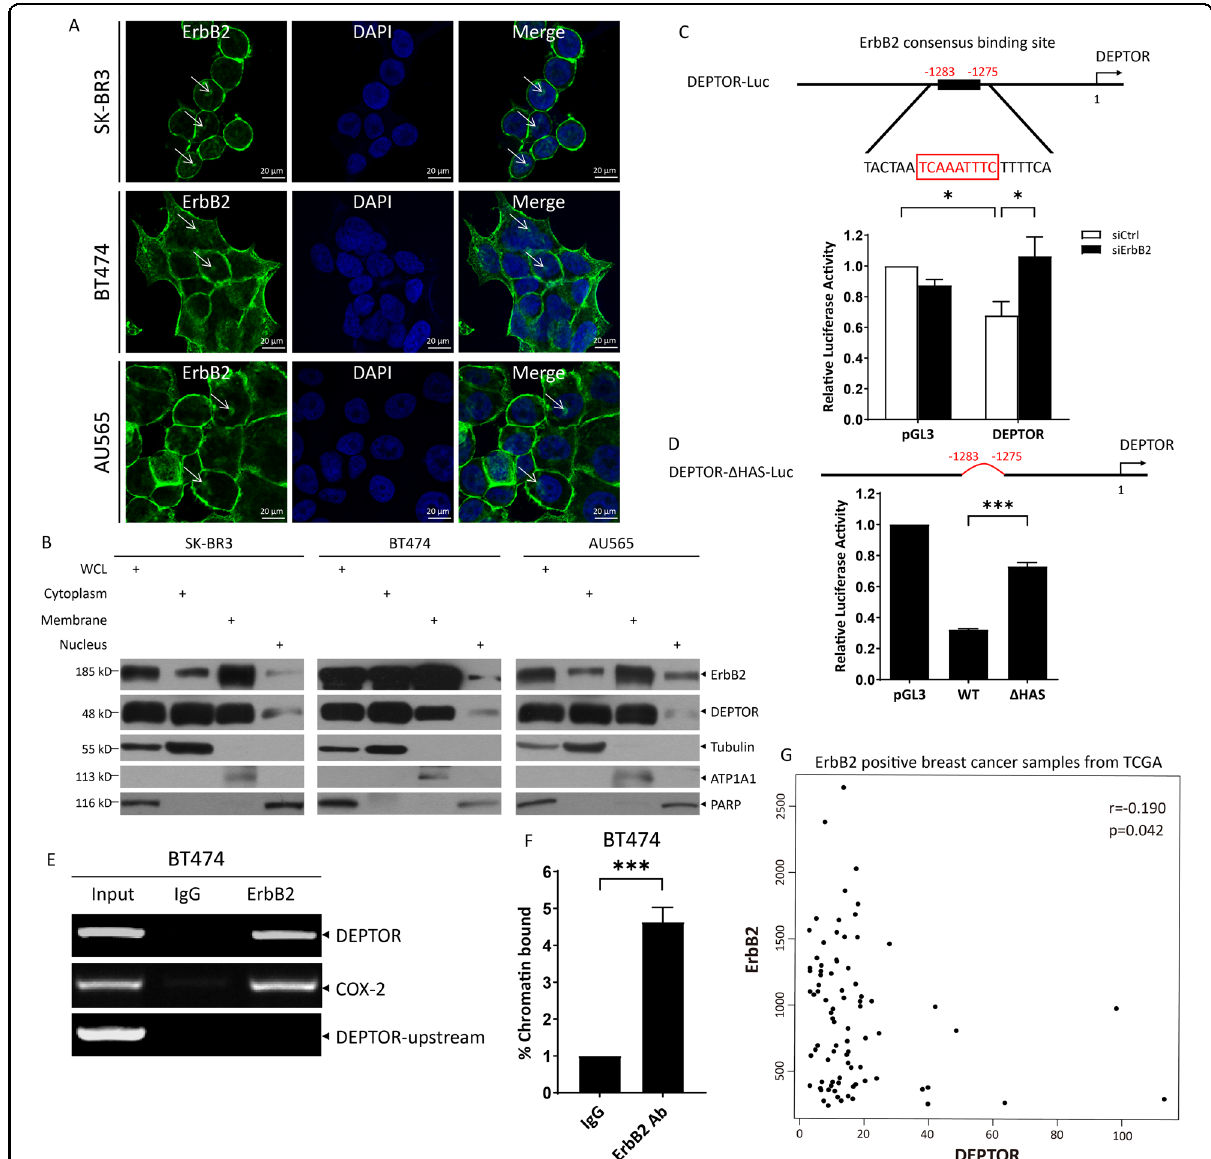
Fig. 2 ErbB2 is translocated to the nucleus and binds to HAS in the DEPTOR promoter. A , B Nuclear translocation of ErbB2: SK-BR3, BT474, and AU565 cells were stained with anti-ErbB2 antibody and photographed using Nikon confocal microscopy ( A ), or harvested for subcellular fractionation, followed by western blotting ( B ). Scale bars represent 20 μ m. Tubulin, ATP1A1, and PARP were used as cytoplasmic, plasmalemmal, and nuclear markers, respectively. C , D Silencing of ErbB2 or deletion of HAS increases DEPTOR transcription. Shown are luciferase reporters under the control of DEPTOR promoter containing the ErbB2 consensus binding site (HAS, − 1283 to − 1275) ( C ) and with HAS deleted (deleting − 1283 to − 1275) ( D ). SK- BR3 cells were cotransfected with the indicated siRNA oligos and luciferase reporter construct (DEPTOR-Luc) for 48 h ( C ), BT474 cells were transfected with the indicated luciferase reporter constructs for 24 h ( D ), followed by luciferase reporter assay. Data from three independent experiments, each run in duplicates, were expressed as mean ± SEM, * p < 0.05, *** p < 0.001. E , F ErbB2 binds to the DEPTOR promoter: fresh BT474 cells were harvested for the ChIP assay with anti-ErbB2 antibody or normal IgG, followed by PCR ampli fi cation of indicated promoter fragments ( E ), or quantitative real- time PCR analysis ( F ). The HAS of COX-2 and the fragment upstream of DEPTOR “ start codon ” ( − 6586 to − 6449, DEPTOR-upstream) were used as positive and negative controls, respectively. G Pearson ’ s correlation between the expression of ErbB2 and DEPTOR in ErbB2-positive BRCA tumor